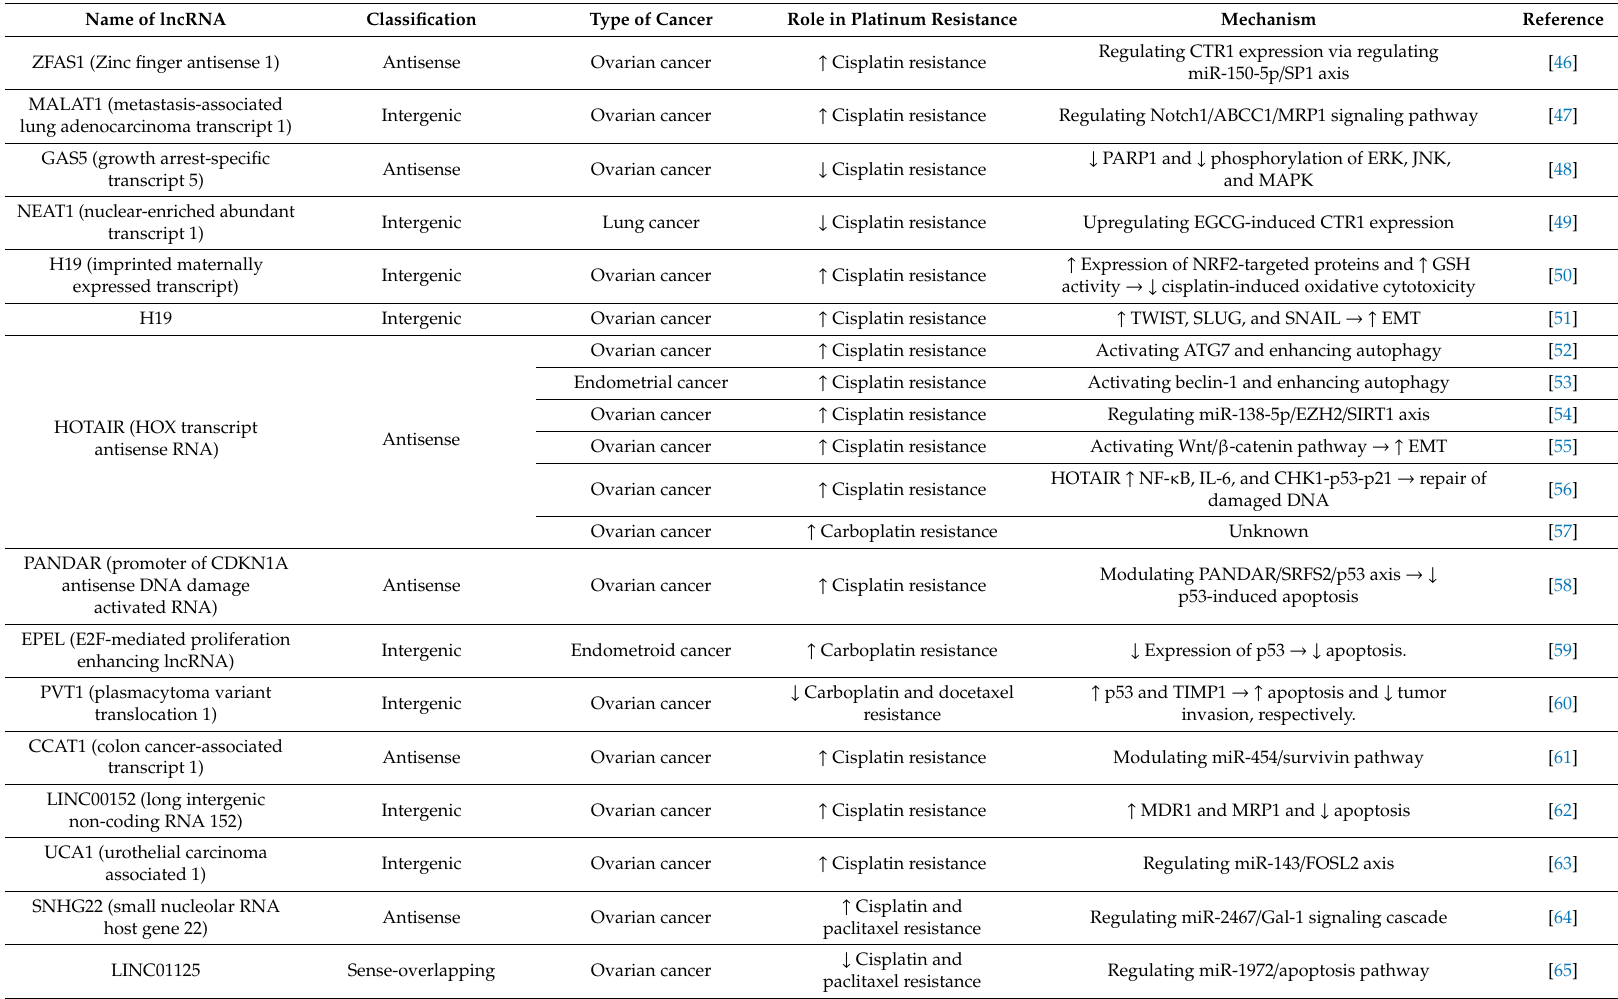
Table 1. List of lncRNAs associated with platinum